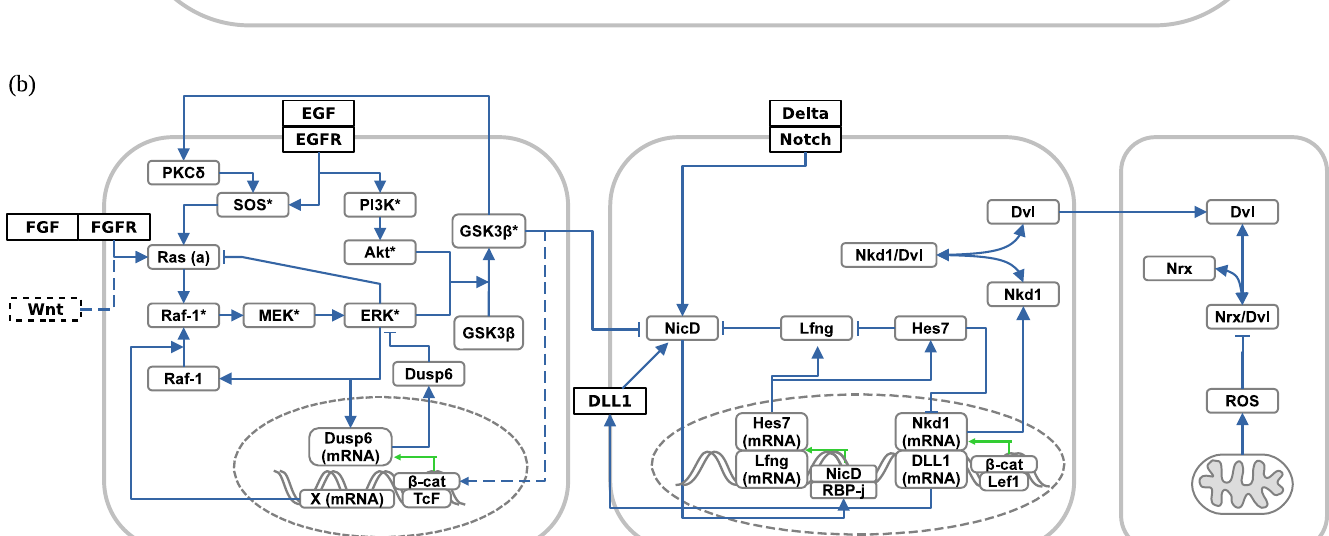
PLOS Computational Biology | https://doi.org/10.1371/journal.pcbi.1009227 August 5,